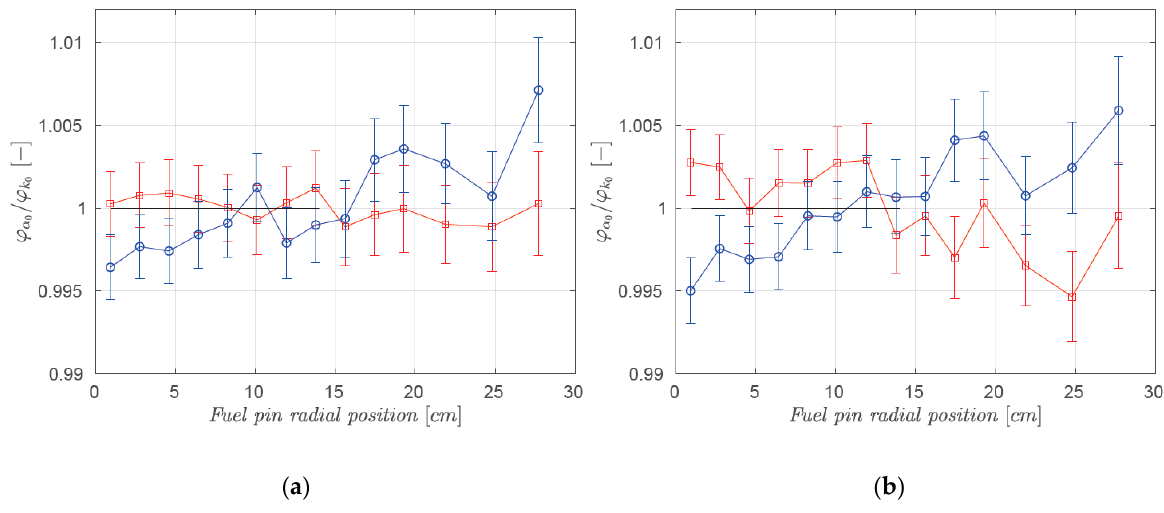
Figure 13. Ratios ϕ α / ϕ of the CROCUS reactor as a function of the energy variable, H1 ( a ) and H2 ( b ) configurations with (red squares) and without (blue circles) precursor contributions.